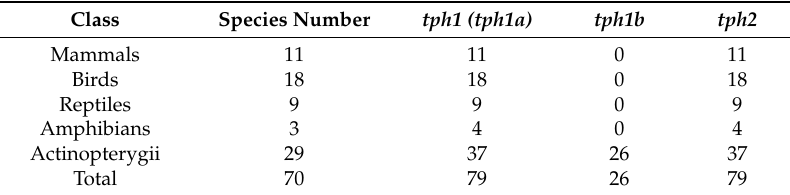
Table 1. Distribution of the tryptophan hydroxylase (TPH) family in the selected vertebrate genomes. Class